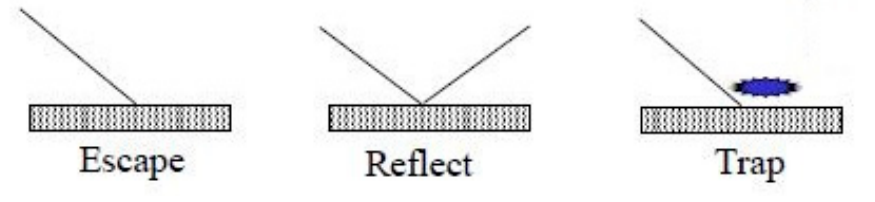
Figure 5. DPM wall boundary conditions.